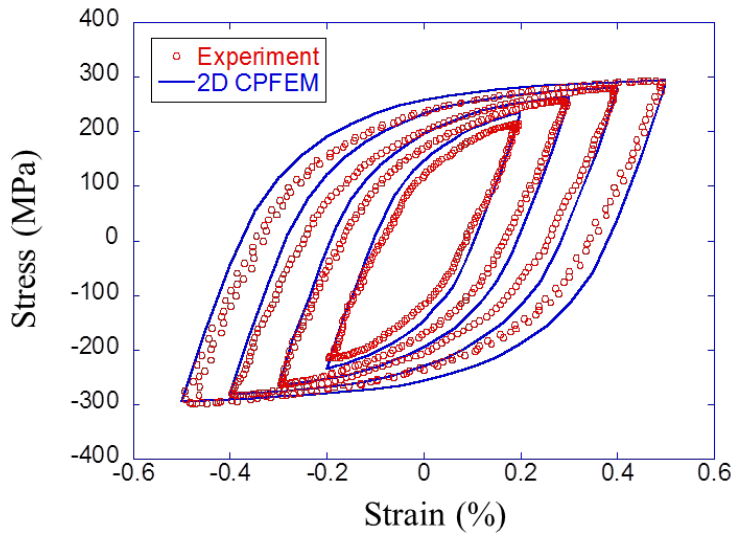
Figure 8. Experimental and calibrated stress–strain hysteresis loop for K1 steel.